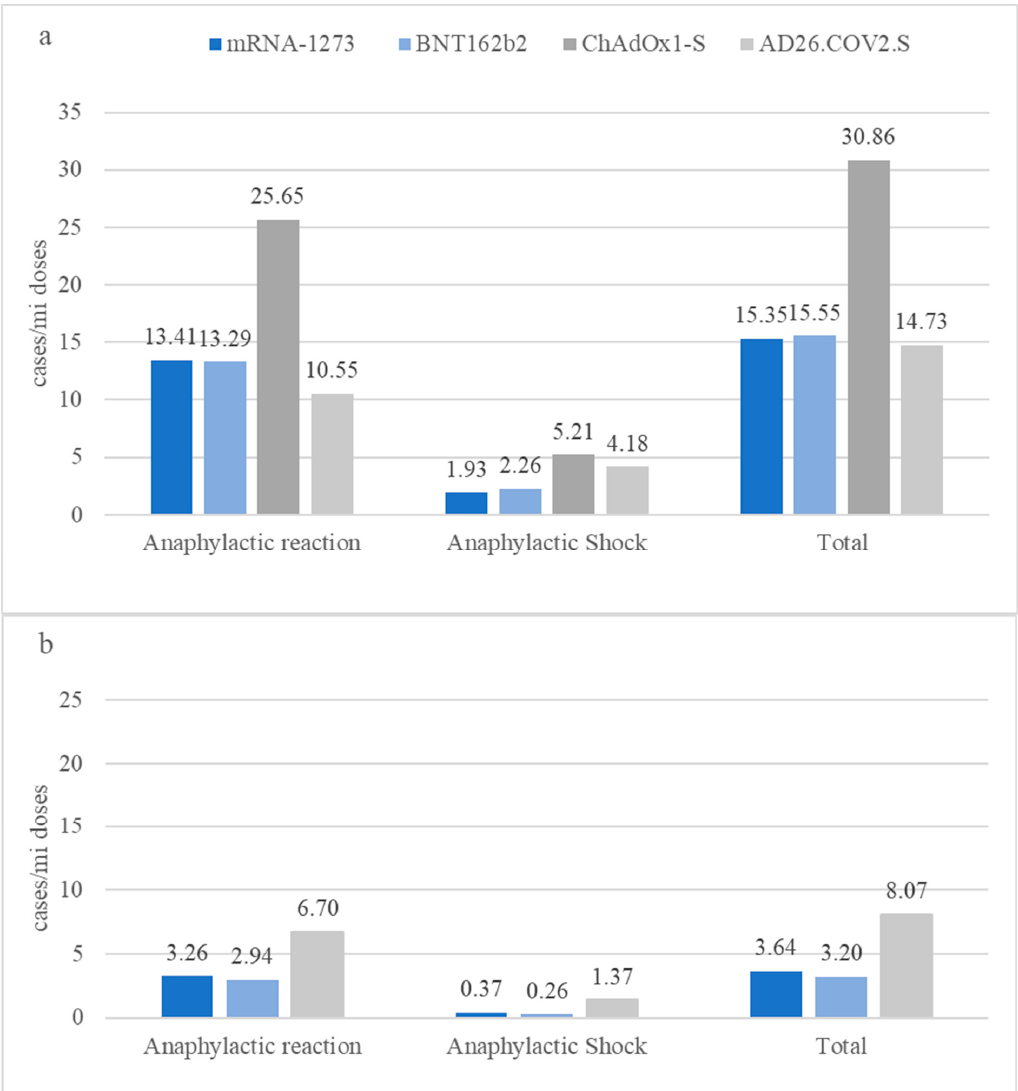
Figure 1. Rates of estimated anaphylactic reaction and anaphylactic shock post-COVID-19- vaccination for licensed vaccines, as reported by the EudraVigilance ( a ) and VAERS ( b ) databases, expressed per million administered doses from week 52, 2020 (ending on 31 December 2020) to week 2 ( a ) or week 1 ( b ), 2023 (ending on 13 January or 6 January 2023,